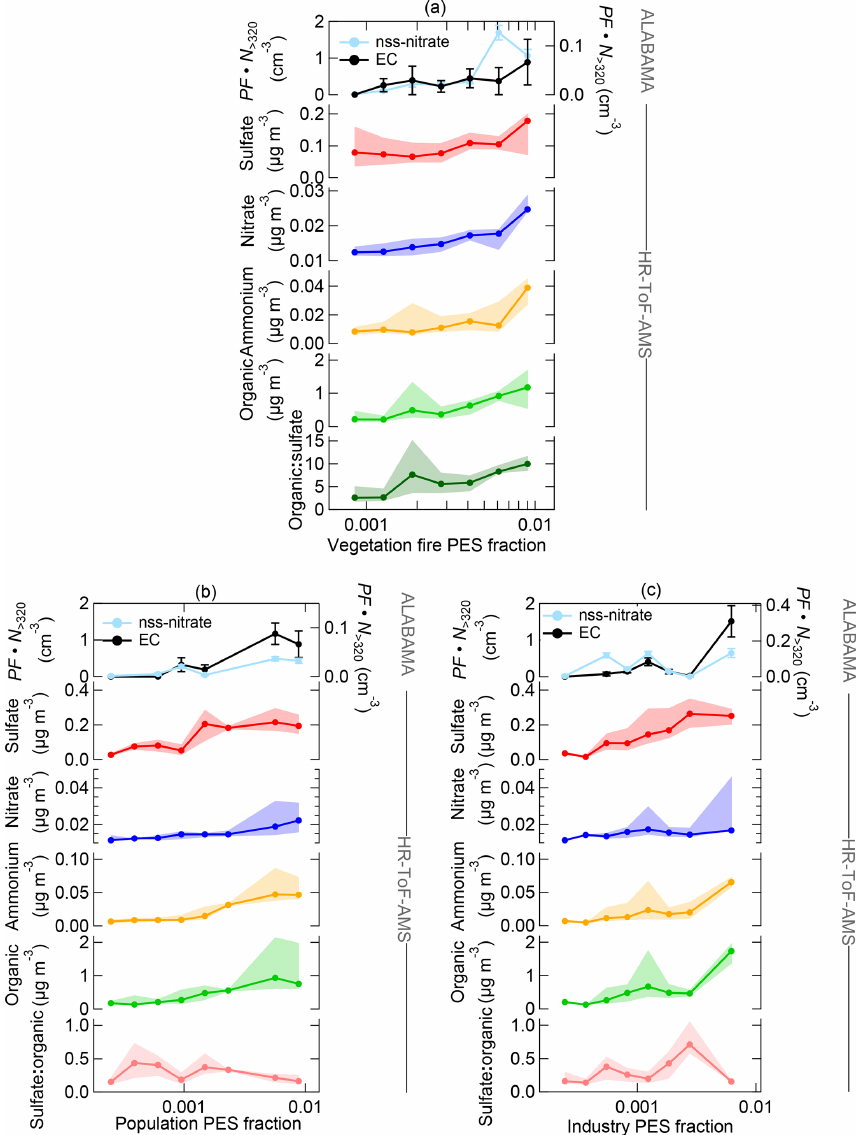
Figure 17. Aerosol composition measured by the ALABAMA and by the HR-ToF-AMS (indicated on the right side) as a function of FLEXPART-derived PES fraction over (a) vegetation fires, (b) populated areas, and (c) industrial areas during the southern air mass period. The top panel represents the scaled ALABAMA number concentration (PF · N > 320 ) with the right axis referring to EC-containing particles (black) and left axis referring to nss-nitrate-containing particles (light blue). Lower panels represent each median (solid line with marker) and interquartile range (shaded area) of the HR-ToF-AMS mass concentrations of sulfate (red), nitrate (blue), ammonium (orange), and organic matter (light green), as well as the organic-to-sulfate ratio (dark green) and the sulfate-to-organic ratio (pink). Uncertainty analyses are given in Sect.